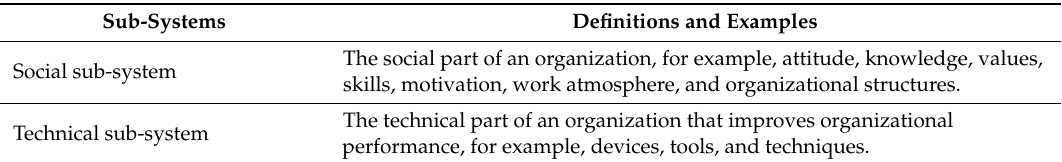
Table 1. Social and technical subsystems.